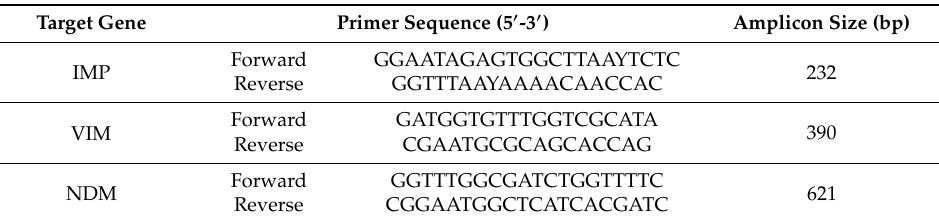
Table 5. Primer sequence used to identify metallo- β -lactamase